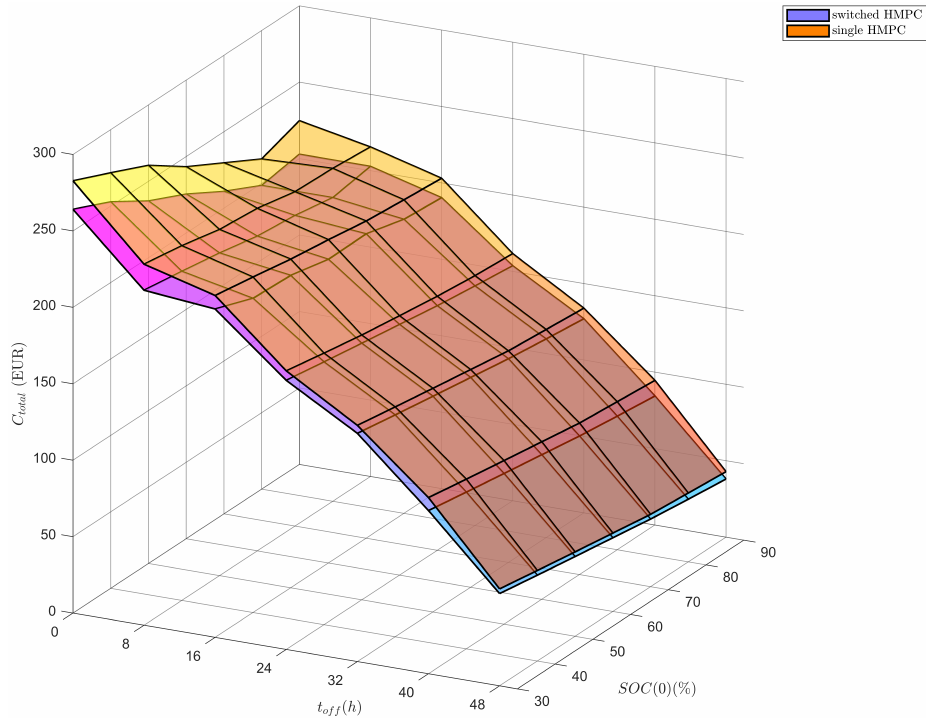
Figure 9. The total cost of microgrid operation depends on the initial storage state of charge and the time at which operation mode is changed from on-grid to